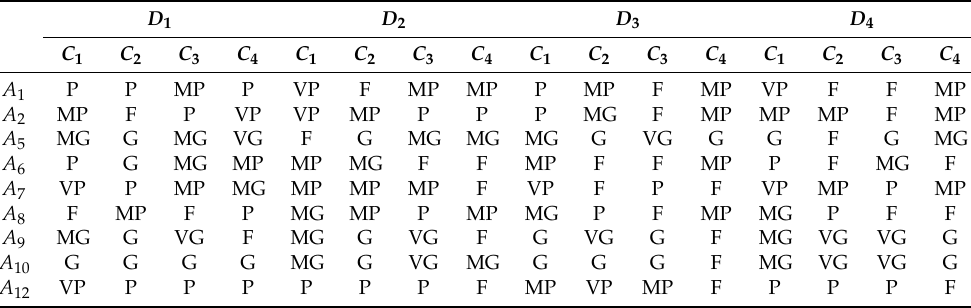
Table 4. The decision-matrix of each decision-maker at third period ( t =